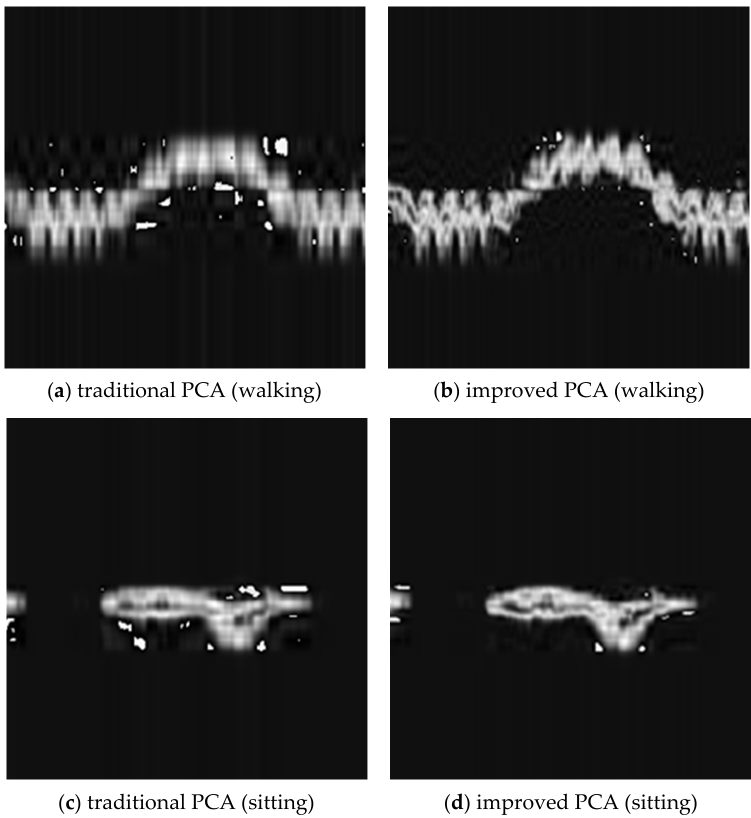
Figure 9. Comparison of spectrograms processed by the improved PCA and the traditional PCA.